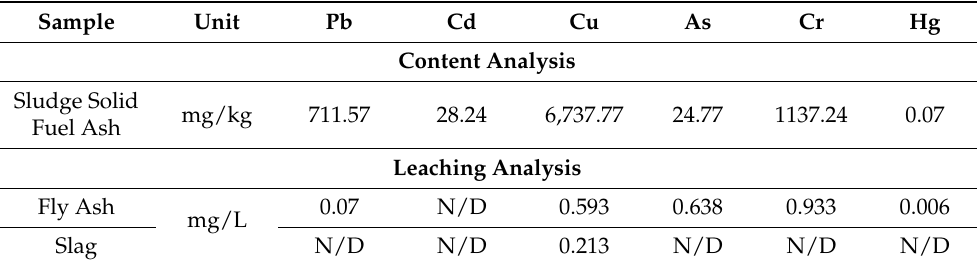
Table 9. Heavy metal concentrations in various sludge, slag, and ash